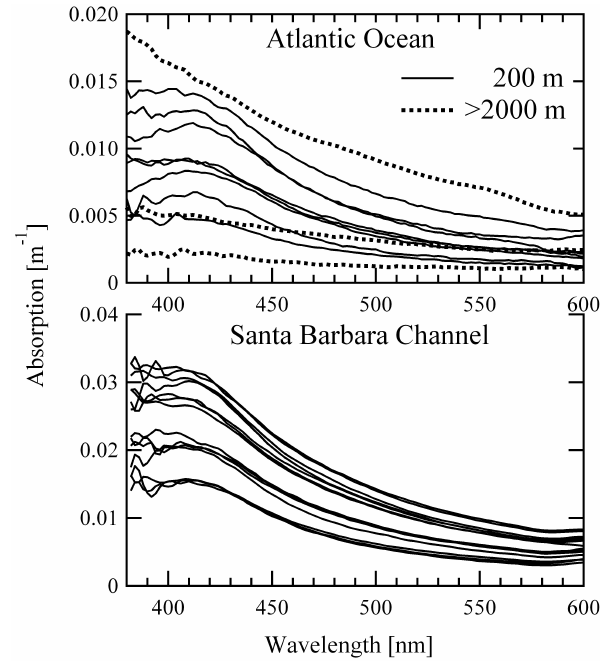
Fig. 6. Light absorption by particles of samples from subsurface depths taken in (a) the western Atlantic Ocean (200m and > 2000m), and (b) the Santa Barbara Channel (California, Northeast Pacific, 80–200m).